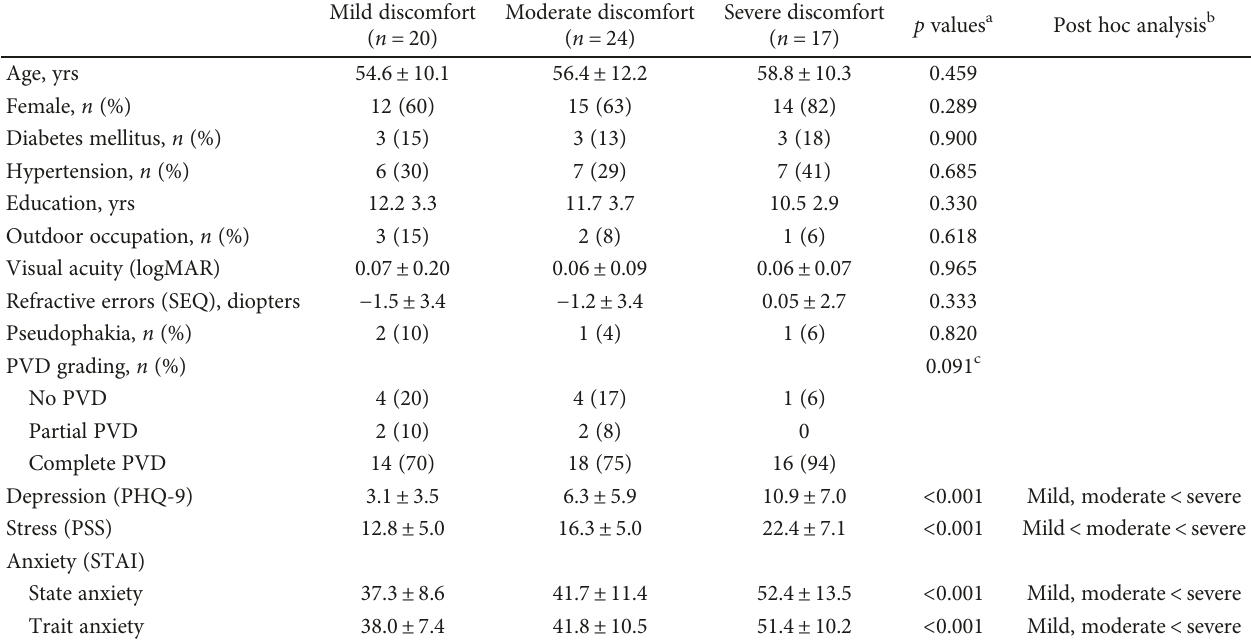
Table 5: Comparison of demographics, posterior vitreous status, and psychologic parameters among di ff erent discomfort severity